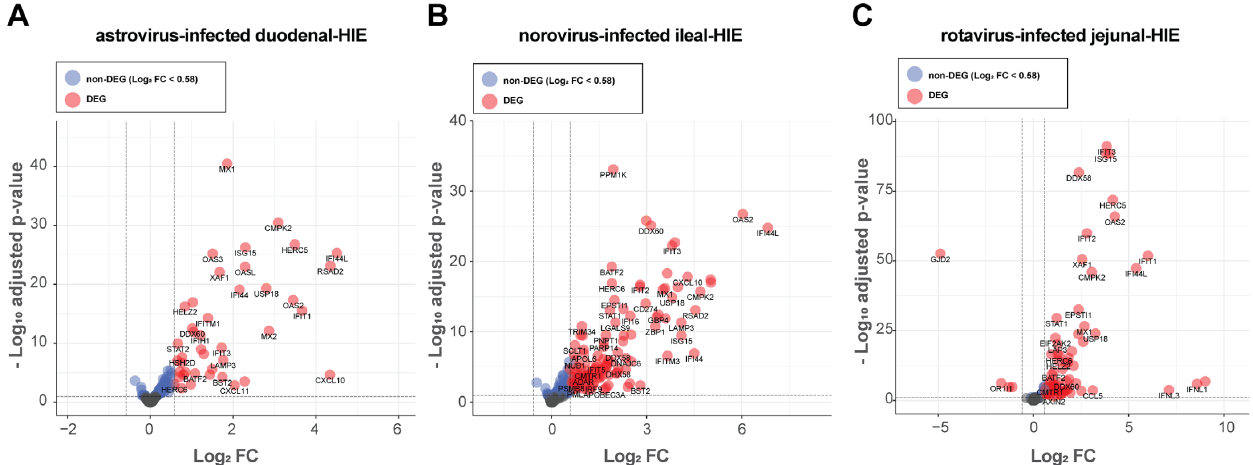
Figure 3. Differential expression analysis in HIEs infected with astrovirus, norovirus and rotavirus. Differentially expressed genes (DEGs) for the three re-analyzed RNA-seq datasets are shown. DEGs with Log 2 fold-change (FC) > 0.58 when compared to mock-treated samples and an FDR of less than 1% are shown red, while genes with an FDR of less than 1% (adjusted p -value < 0.01) that were below the Log 2 FC threshold are shown in blue. FDR was calculated using an Empirical Bayes (EB) approach with the R package ashr. DEGs were identified in astrovirus-infected duodenal-HIEs ( A ), norovirus-infected ileal-HIEs ( B ) and rotavirus-infected jejunal-HIEs ( C ) using the package DESeq2 and plotted using the package EnhanceVolcano in